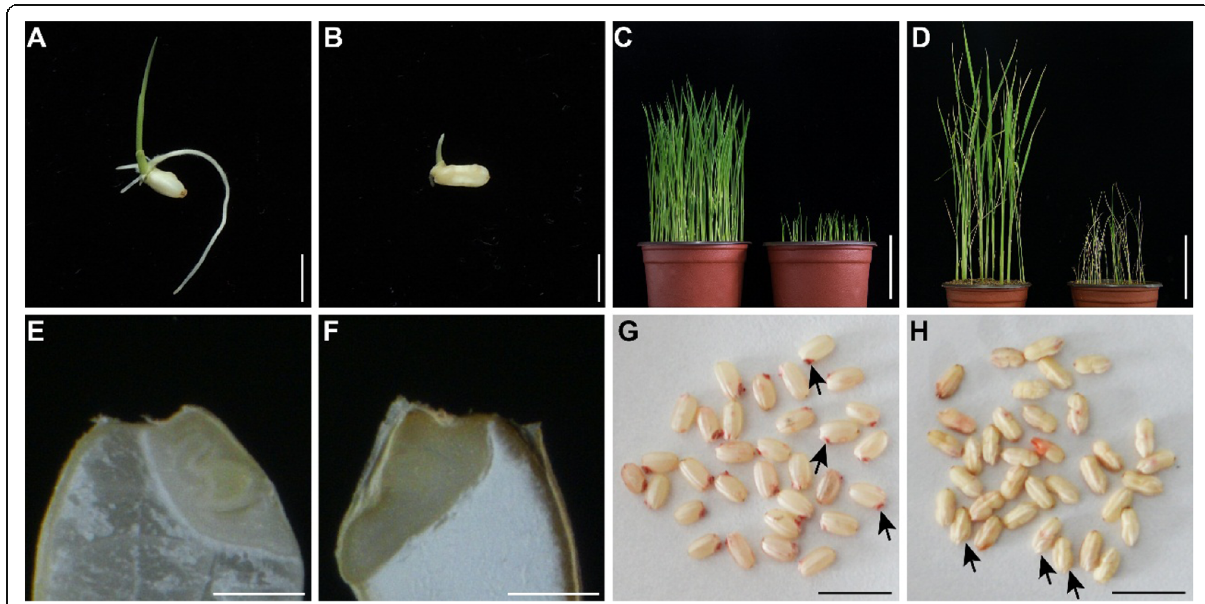
Fig. 2 Seed germination and seedling phenotypes. A and B, Germinating seedlings of WT ( a ) and fse5 mutants ( b ) at 3 DAS. Bars, 5 mm. c and d Seedlings grown from WT (left) and fse5 (right) seeds at 9 DAS ( c ) and 30 DAS ( d ). Bars, 5 cm in ( c ) and 10 cm in ( d ). e and f Longitudinal sections of mature WT ( e ) and fse5 ( f ) seeds after 24 h of imbibition. Bars, 1 mm. g and h TTC staining of WT ( g ) and fse5 ( h ) seeds. The black arrows indicate embryos after staining. Bars, 1